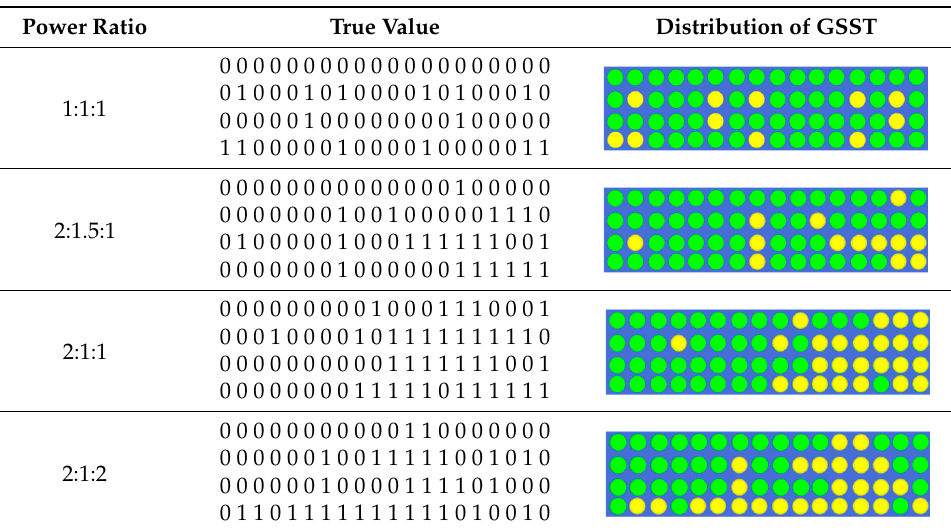
Table 2. Truth tables of 1 × 3 power splitter corresponding to different split ratios. The detailed c-GSST state distribution of four power ratio cases are presented.